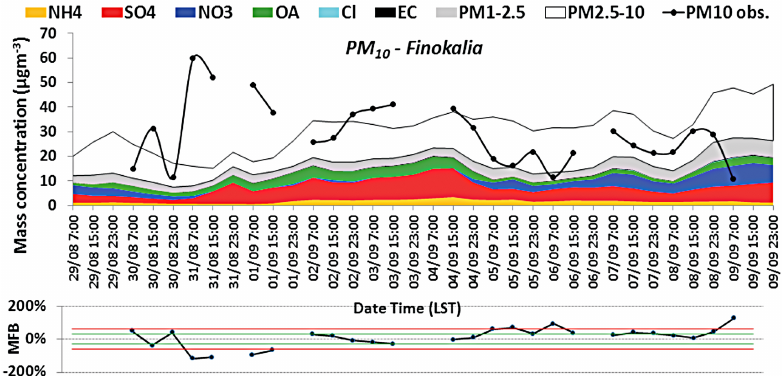
Figure 7. Comparison of PMCAMx (total shaded area) with 8-h measurements (black dotted line) of PM 10 concentrations (µgm − 3 ) over Finokalia during 31 August–09 September 2011. Colour shaded areas represent the chemical composition of PM 1 predictions, the grey shaded area shows the PM 1 − 2 . 5 , while the remaining (white shaded area) represents the coarse fraction (PM 2 . 5 − 10 ) . The ability of the model to reproduce observations is estimated through the calculation of the mean fractional biases (MFB), shown at the bottom. Model performance is average (good), when MFB values are within the red (green) lines (Boylan and Russell,